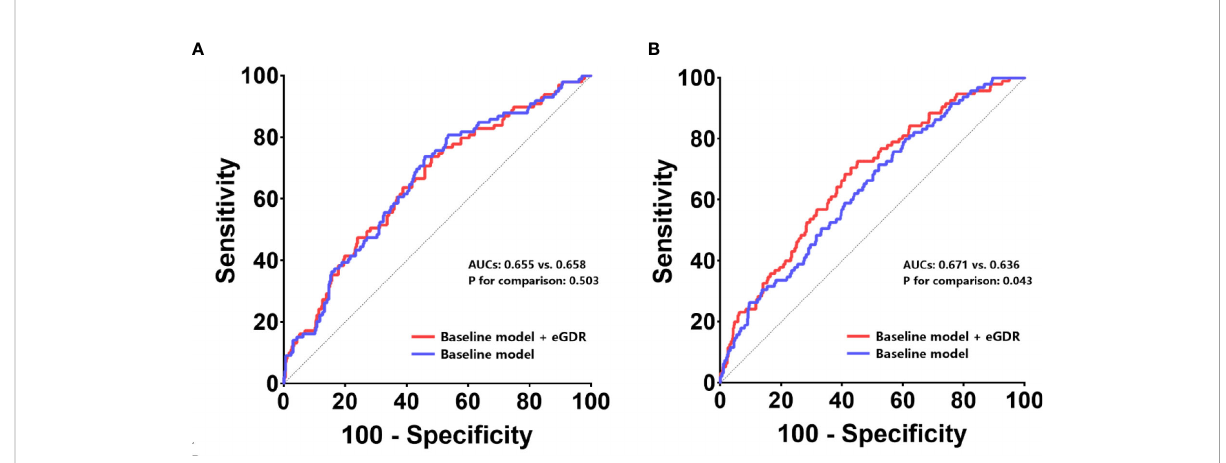
FIGURE 4 ROC curves to assess the predictive value of eGDR for ISR in populations with and without T2DM. The predictive values of the eGDR and baseline models were assessed in populations with T2DM (A) and without T2DM (B) . ROC receiver-operating characteristic, eGFR estimated glomerular fi ltration rate, ISR in-stent restenosis, AUC area under curve, T2DM type 2 diabetes